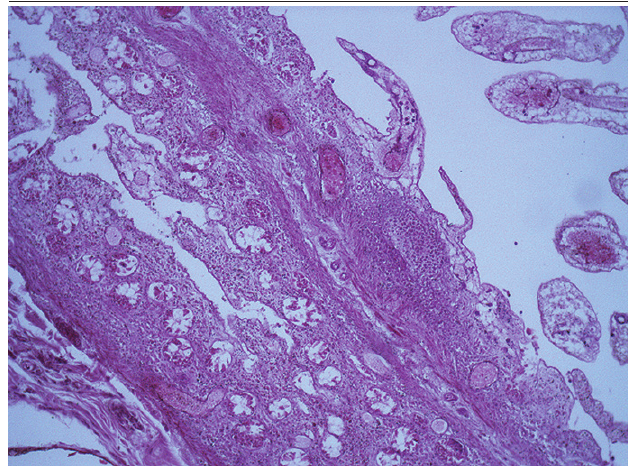
figurE 7 − Histological section of jejunum with transmural coagulative necrosis, HE 100× HE: hematoxylin and eosin.